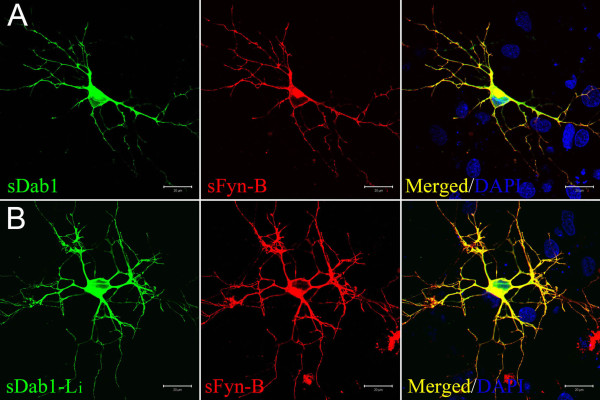
Co-localization of sDab1 isoforms and sFyn-B in transfected primary neurons. A: sDab1 -GFP and sFyn-B-DsRed were co-transfected into DIV6 primary hippocampal neurons. B: sDab1-Li-GFP and sFyn-B-DsRed were co-transfected into DIV6 primary hippocampal neurons. 24 hours after transfection, the cells were fixed and counterstained with DAPI (blue) for nuclei. Scale bars: 20 μm.